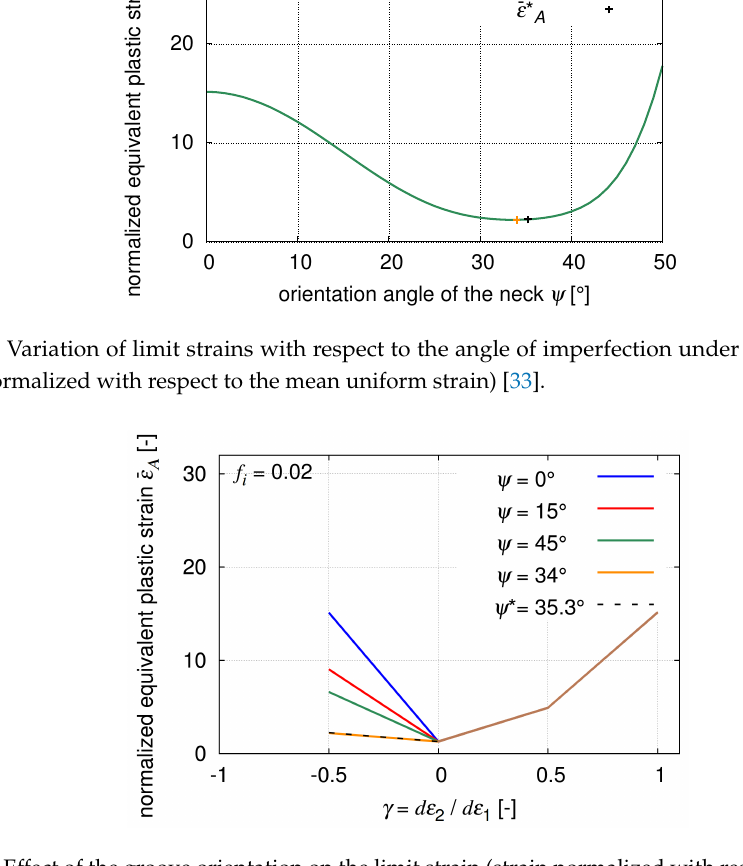
Figure 9. Effect of the groove orientation on the limit strain (strain normalized with respect to the mean uniform strain)